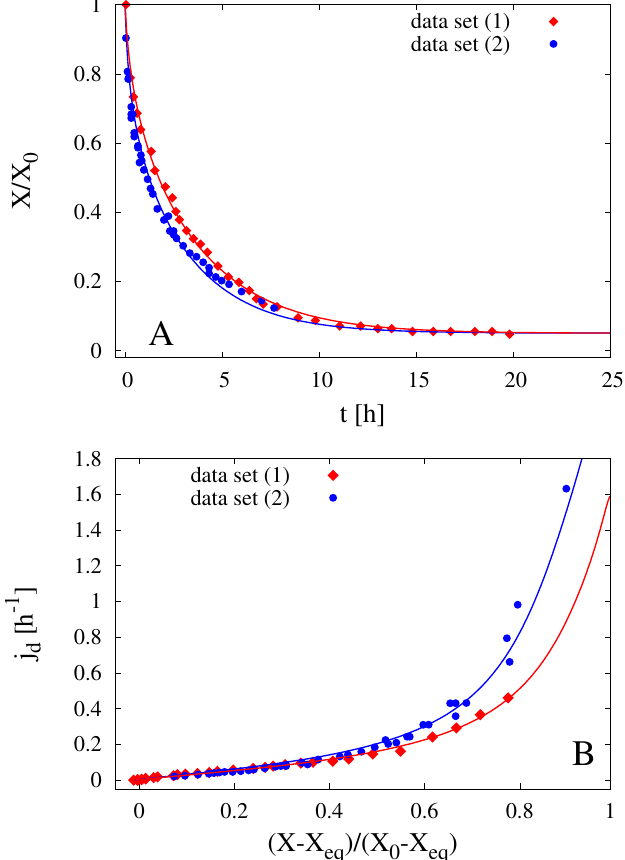
Figure 12. Dehydration kinetics at T = 60 ◦ C and v = 0.6 m/s for two different types of cocoa beans (data set (1) and data set (2)), characterized by two different initial water distributions and final shrinkage, see Table 4. Comparison between experimental data and model predictions with D = 3.12 × 10 − 10 m 2 /s and Bi m = 13.61 for data set (1) and Bi m = 12.87 for data set (2). ( A ) Rescaled moisture content X / X 0 vs. time (h). ( B ) Dehydration rate j d (h − 1 ) vs. moisture ratio X r